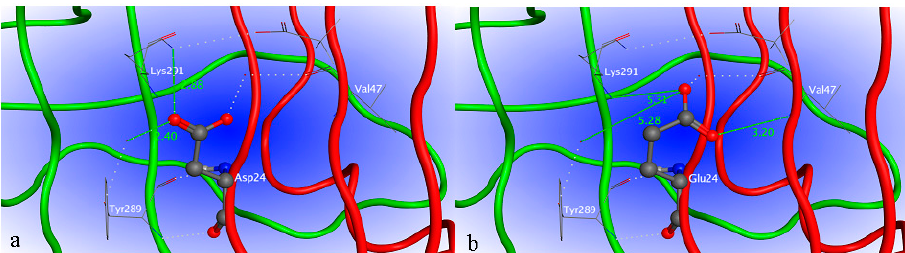
Figure 4. Part of the tertiary structure of H 1-2 P 3 H 4 P 5-6 H 7-8 before and after amino acid replacement at position 24, constructed using MOE (Molecular Operating Environment). Amino acid residue 24 is shown as a ball and stick structure. The carbon atoms are shown in gray ball, the oxygen atoms are shown in red ball, the nitrogen atoms are in dark blue ball. Backbones of two neighboring monomers are shown in red and green. ( a ) 3D structure with amino acid residue D24; ( b ) 3D structure with amino acid residue E24.